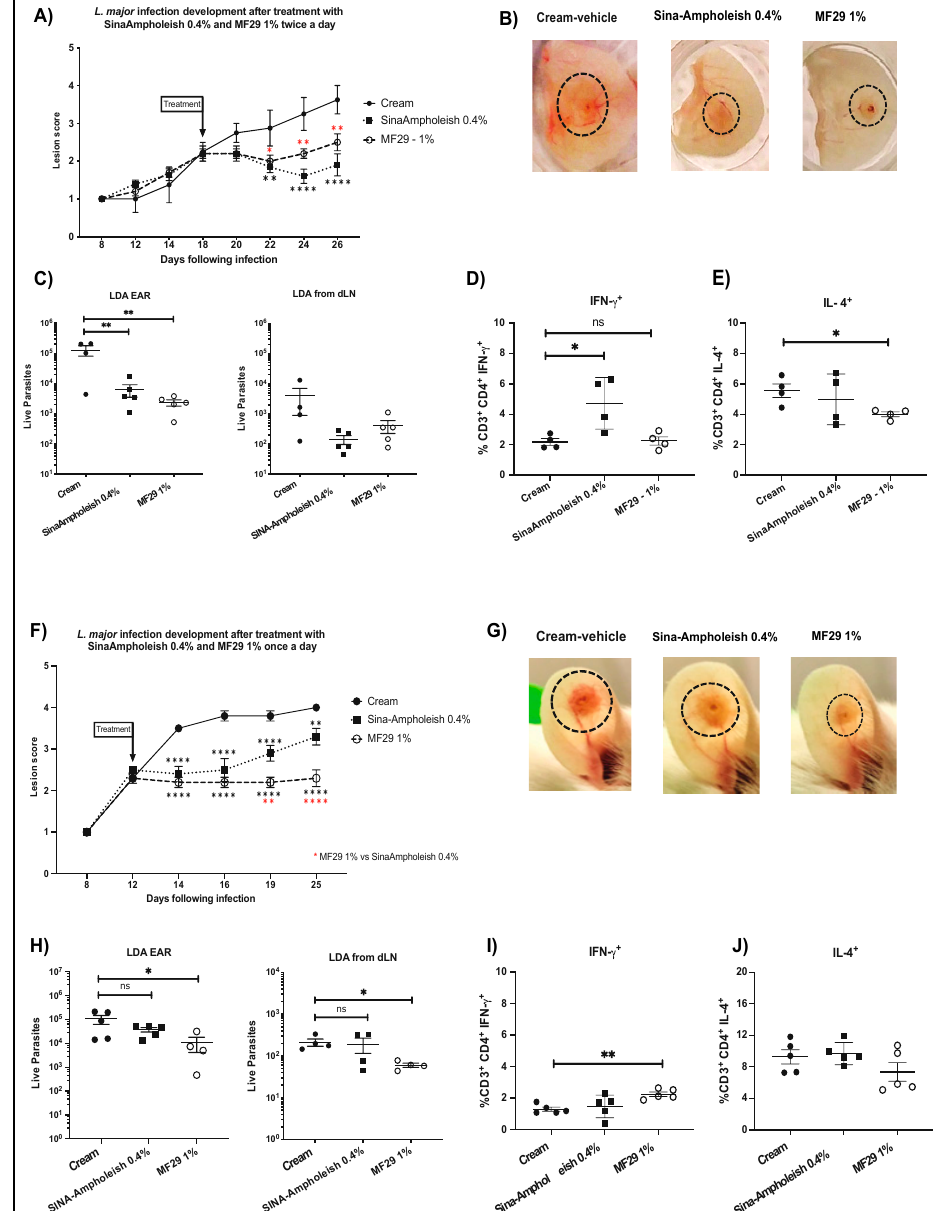
Figure 6. Comparison of MF29 and SinaAmpholeish topical treatments. BALB/c mice were infected i.d. with metacyclic L. major LV39-mCherry and lesion development was scored daily. Once the lesion reached a score of 2: ( A ) SinaAmpholeish 0.4%, MF29 1%, or cream vehicle were applied twice a day in each group of mice. Lesion score development was analyzed. ( B ) Representative pictures in each group at 26 days post-infection. ( C ) Twenty-six days post-infection, parasite load in the ear and dLN were analyzed by limiting dilution assay. ( D ) The frequency of CD4 + IFN- γ + and ( E ) CD4 + IL-4 + production in dLN T cells was analyzed by flow cytometry. ( F ) Lesion development of mice treated once a day with MF29 1%, SinaAmpholeish 0.4% or vehicle cream. ( G ) Representative pictures of an infected ear at the end of the different treatments. ( H ) Parasite load from ear and dLN were determined by LDA. The IFN- γ + ( I ) and IL-4 ( J ) production by CD4 + dLN T cells was analyzed by flow cytometry. For the infection data are represented as mean ± SEM, Two-Way ANOVA (Bonferroni’s post-hoc test) * p < 0.0332, ** p < 0.002, **** p < 0.0001, ns = not significant. For the LDA and cytokines, One-Way ANOVA non-parametric T -test (Dunn’s post-hoc) * p < 0.05, ** p < 0.002, ns = not significant. The data are representative of two experiments with 5 mice /